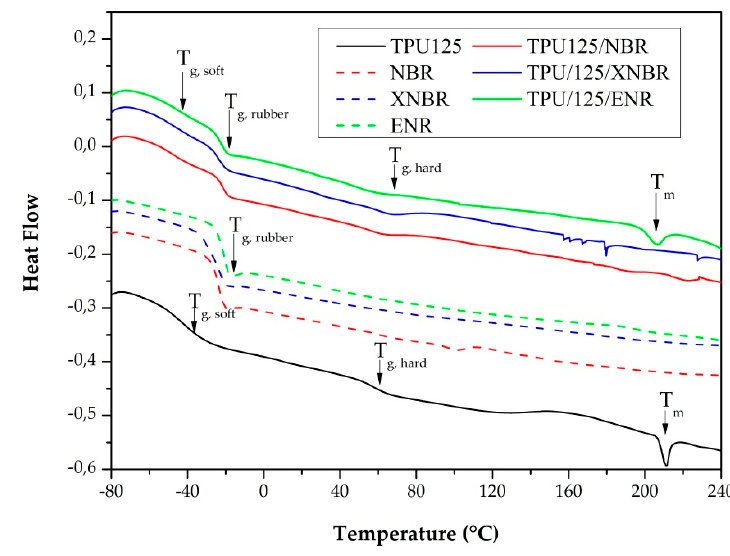
Figure 10. DSC thermograms of the TPU matrix and the TDVs.